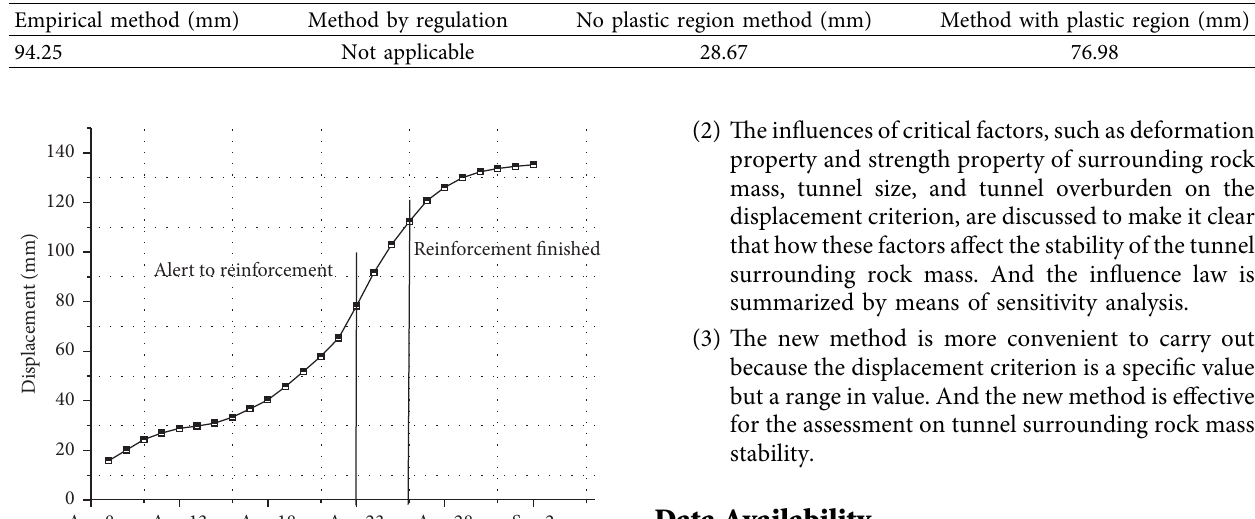
Table 5: Allowable displacement by different methods for the tunnel at Zipingpu project.